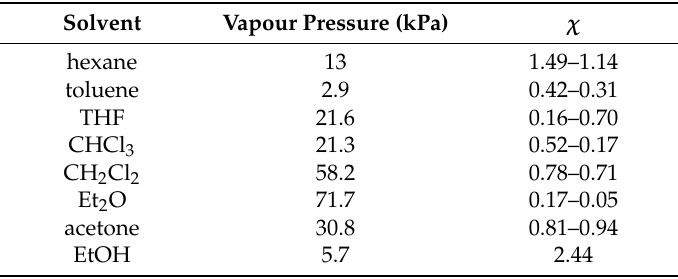
Table 3. Vapour pressure of different solvents at 25 °C,[42] PS-solvent Flory-Huggins interaction parameter χ ,[43] for the investigated volatile organic compounds (VOCs).